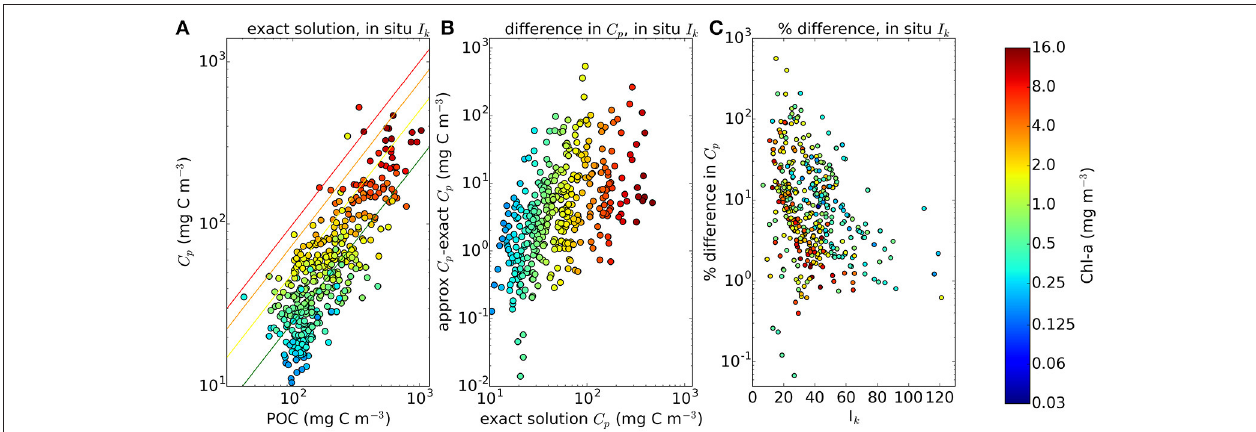
FIGURE 3 | Comparison of phytoplankton Carbon estimates using the approximate and exact solution with in situ I k data from around 400 samples, mostly from the N.W Atlantic region. (A) Calculated Phytoplankton Carbon ( θ ∗ B ) in relation to POC measured for the BIO samples using the exact solution. Red, orange, yellow and green lines correspond to phytoplankton carbon equalling 100, 75, 50, and 25% of POC respectively. The θ m values are calculated using an estimate of the community size structure calculated using the method of Brewin et al. (2010). (B,C) show the absolute and % difference between results from the exact and approximate solutions.